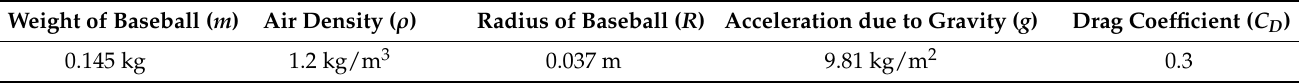
Table 2. Physical parameters of a pitched baseball.